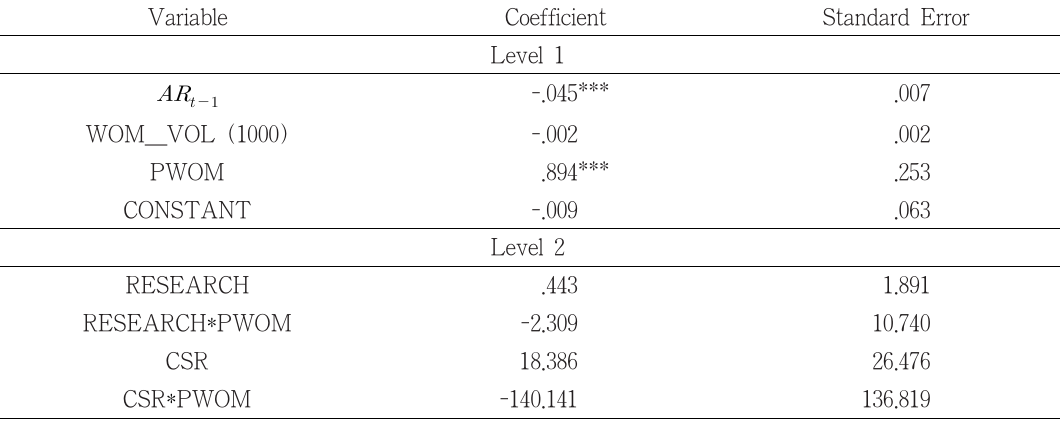
<Table 8> Parameter Estimates of the Model with